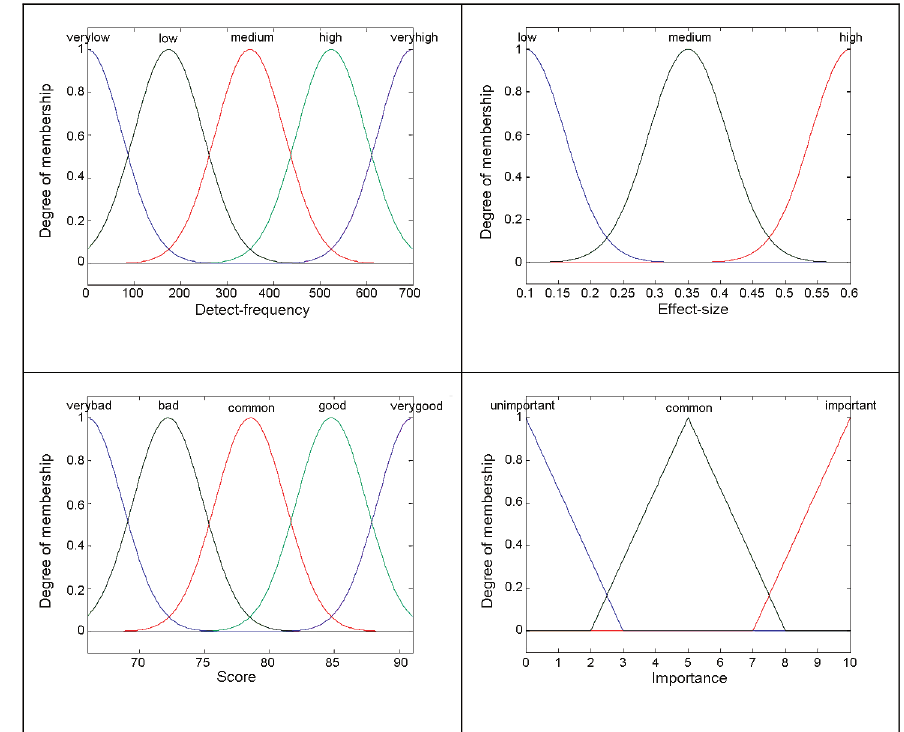
Figure 2. Linguistic